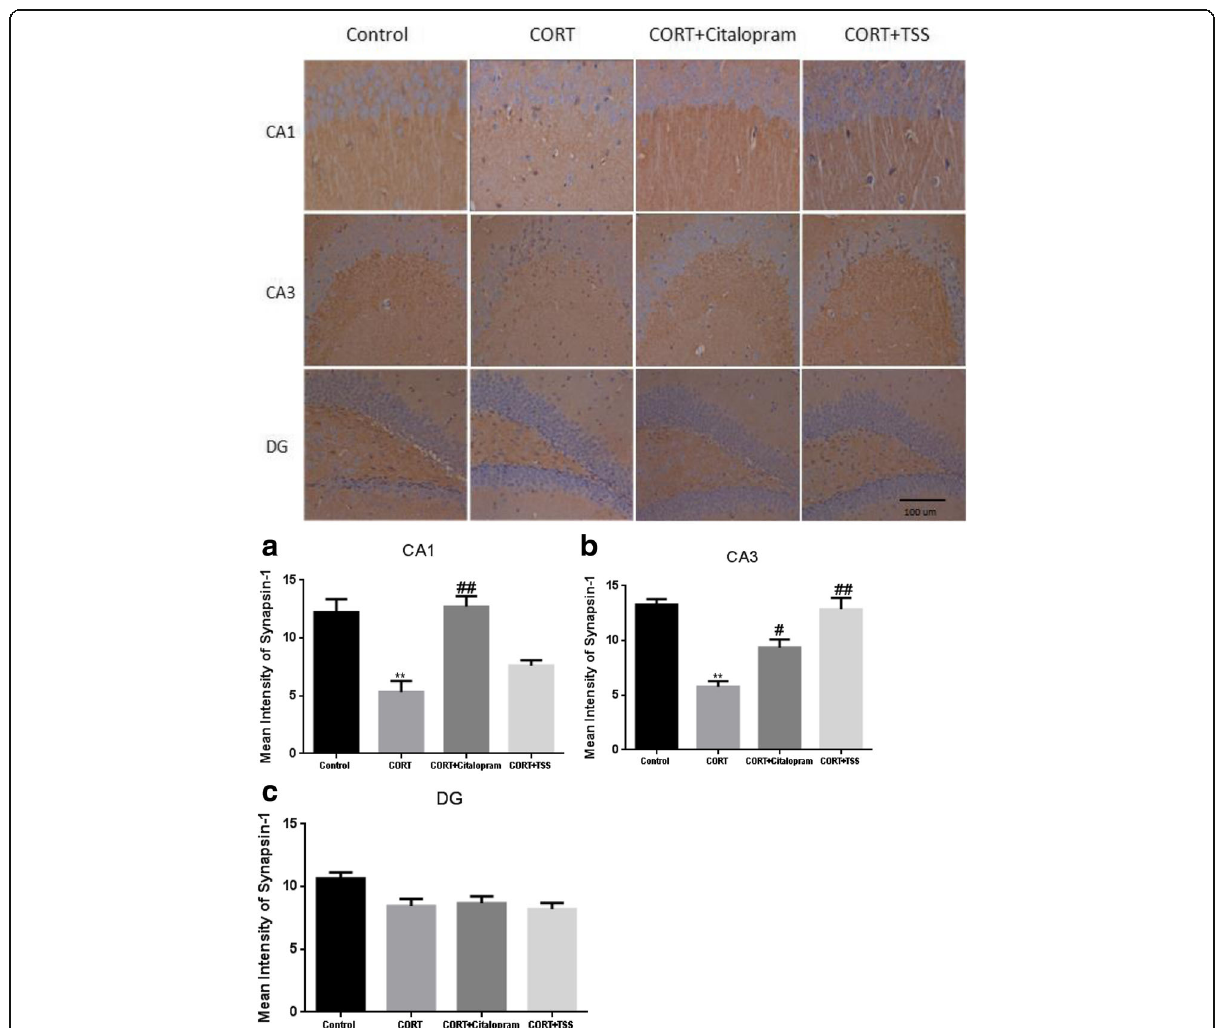
Fig. 8 Immunohistochemical analysis of synapsin-1 in the CA1 ( a ), CA3 ( b ) and DG ( c ) of hippocampus after TSS (25 mg/kg) and citalopram (10 mg/kg) treatment in chronic corticosterone-treated mice. Data were analyzed by one-way ANOVA followed by Student-Newman-Keuls test. Each bar represents the mean ± SEM. ** P < 0.01, as compared with the control group and ## P < 0.01, # P < 0.05, as compared with the CORT